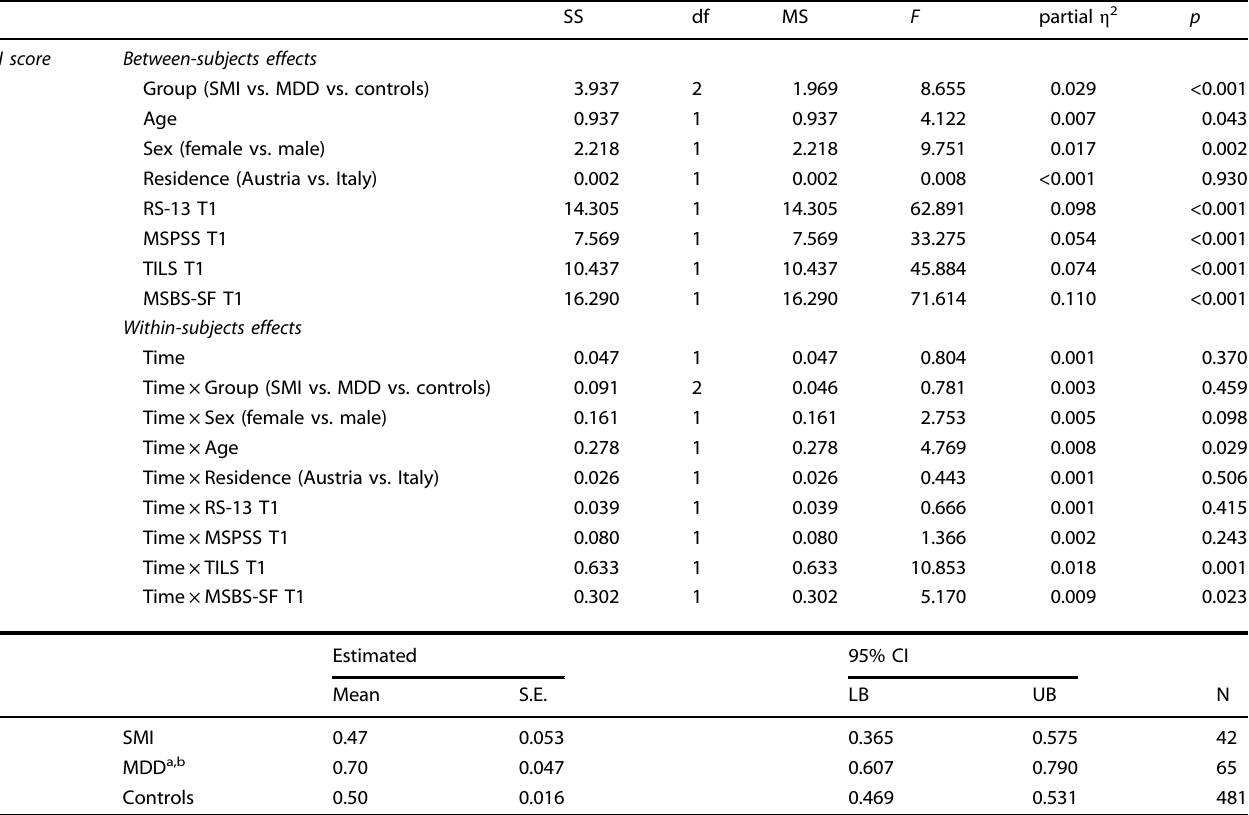
Table 6. Repeated Measures ANCOVA (z-standardized).